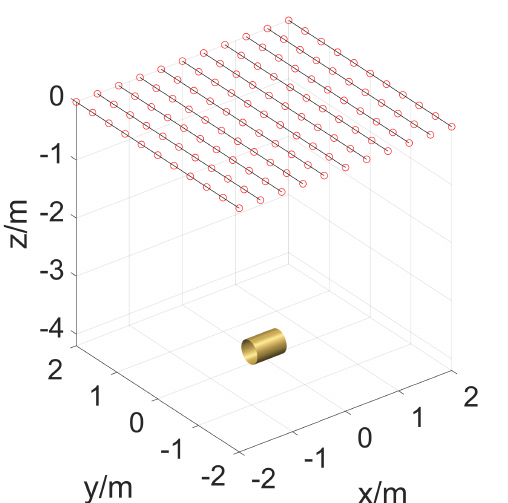
Figure 6. Cylinder in the detection system.